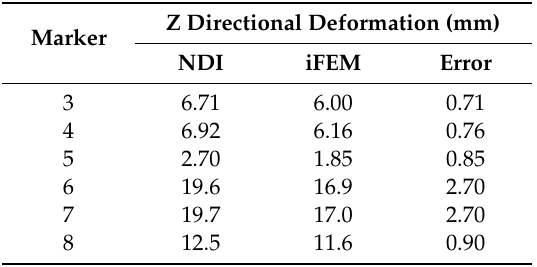
Table 3. The results of markers